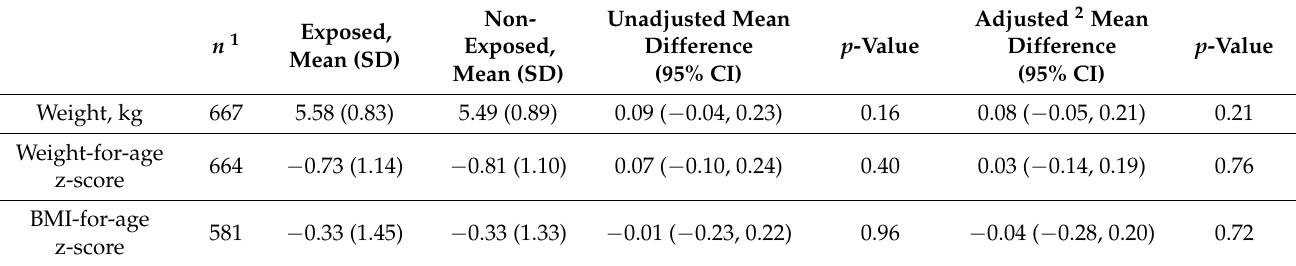
SD, standard deviation; CI, confidence interval. 1 Sample size for analysis of each infant outcome. 2 Adjusted for maternal age (years), race/ethnicity (white, black, Hispanic, other), household income (<$35,000, $35,000–$74,999, ≥ $75,000), education level (high school or less, some college, college or above), marital status (yes/no) and gestational diabetes status (yes/no), pre-pregnancy BMI (kg/m 2 ), gestational weight gain (GWG, pounds), total energy intake (kcal/day), sugar-sweetened beverage (SSB) intake (servings/month), infant’s birth weight (pounds), and exclusive breastfeeding